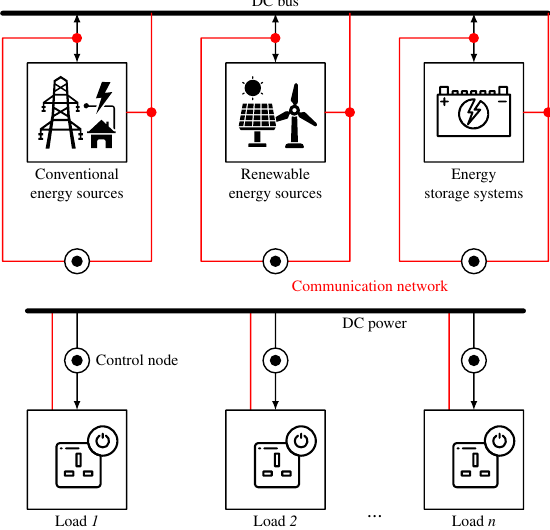
Figure 7. Hybrid distributed nanogrid